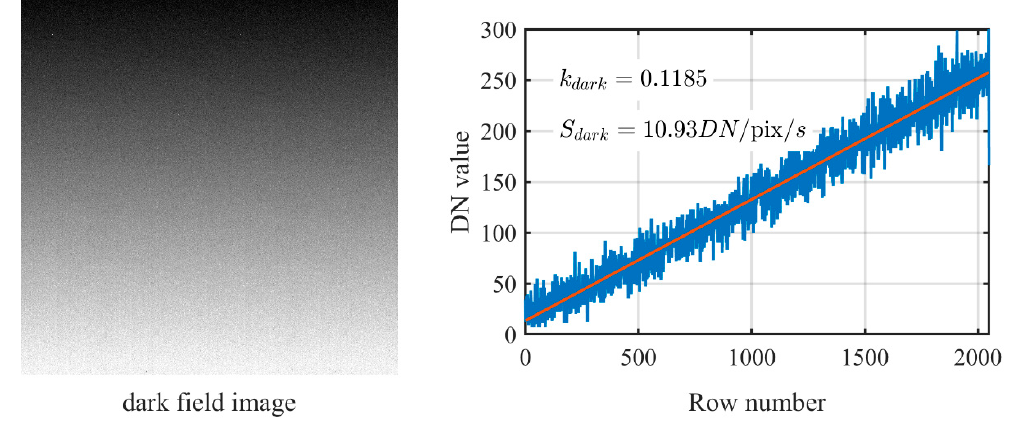
Figure 5. Dark signal measurement results of red band NIMO CCD at − 30 °C. The whole test and fitting results of the dark signals as a function of temperature for red channel NIMO CCD are shown in Figure 6. The results show that the measured data and fitting equation can match very well with the determination coefficient R-squared = 0.9997, and the fitting equation in the unit of electrons converted by the gain of 1.65e/DN is shown in the Equation (10).